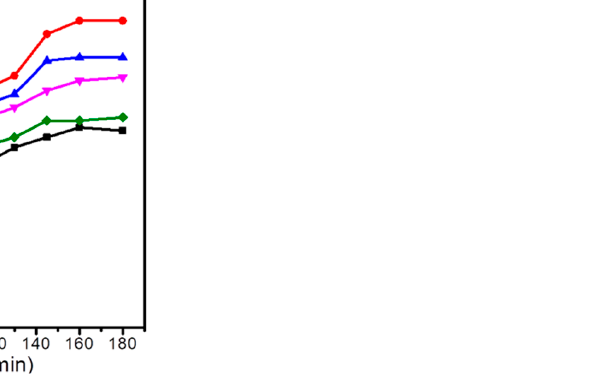
Figure 6. Effect of catalyst dose on photocatalytic degradation of amoxicillin (C0 = 15 mg/L, pH = 9).